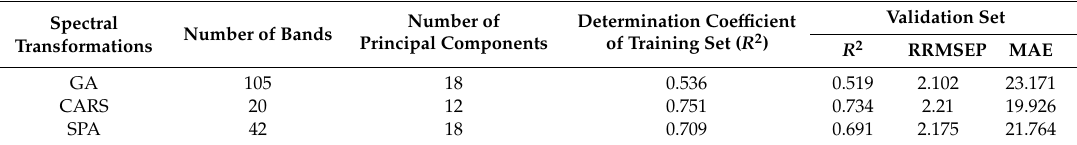
Table 4. PLS model accuracy of di ff erent band selection methods.